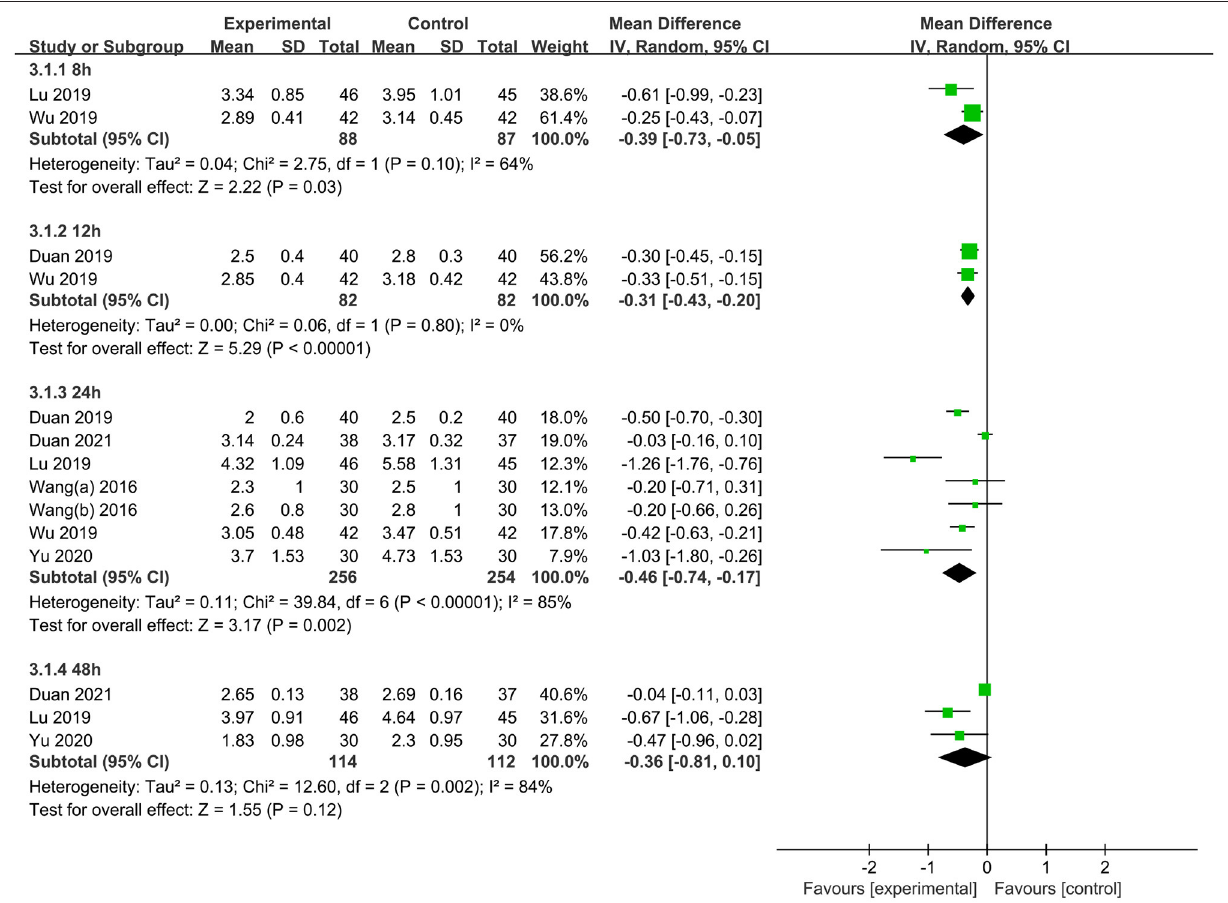
FIGURE 5 | Meta-analysis and forest plot for VAS scores at different periods.